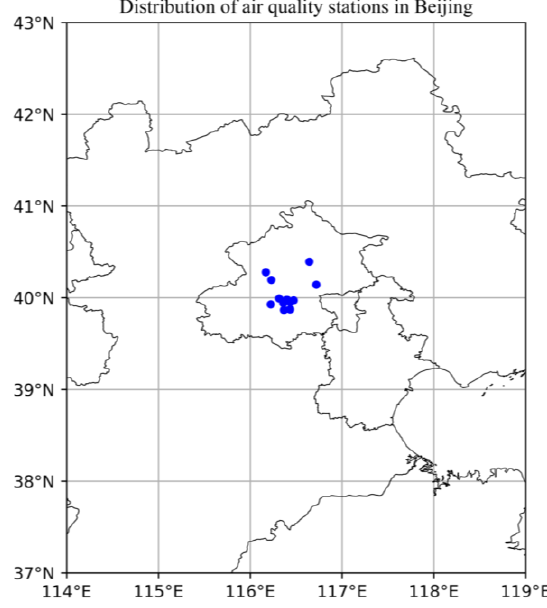
Figure 2. Locations of the air quality monitoring stations in Beijing. Table 1. Location of L-band radar station and numbers of clean days and polluted days in Beijing.